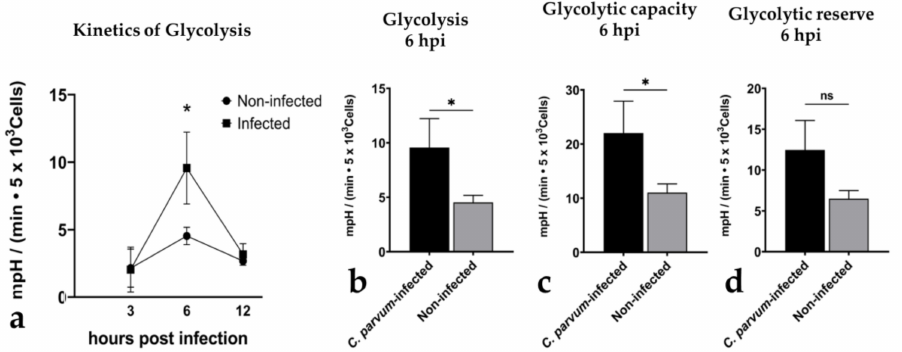
Figure 7. Glycolytic responses in Cryptosporidium parvum -infected BSIEC. Glycolytic responses were monitored via extracel- lular acidification rates (ECAR) in C. parvum -infected and non-infected BSIEC at 3, 6, and 12 hpi, evidencing a parasite-driven upregulation of glycolysis ( a , b ) and glycolytic capacity ( c ) at 6 hpi. An increase in glycolytic reserve was also observed ( d ), but proved barely significant. Statistical significance (* p < 0.05, ns = non-significant) was determined via t -test, comparing infected to non-infected (controls), followed by Dunnett’s test correction. Bars represent mean ± SD ( n =